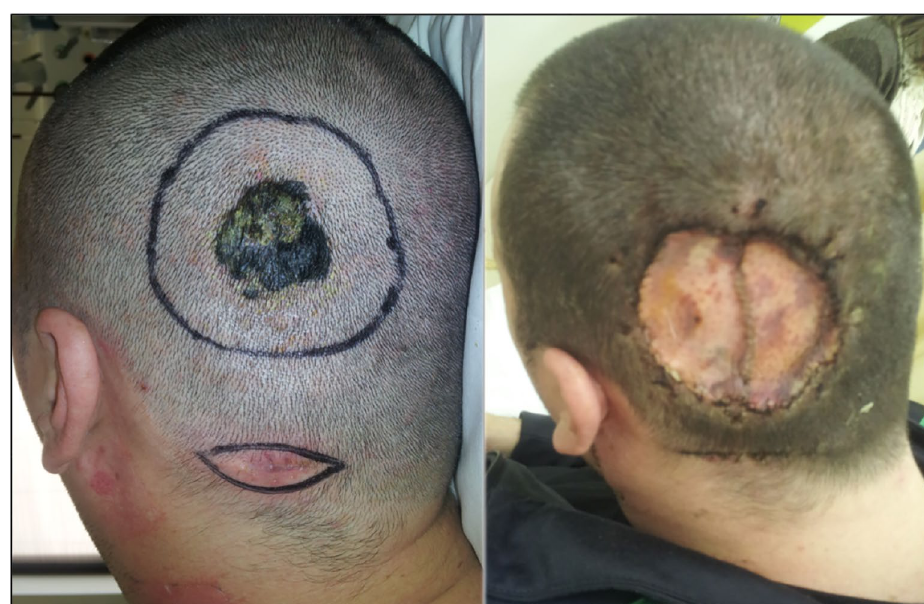
Figure 2. Clinical image of a 28-years-old man with a superficial spreading melanoma, with a Breslow thickness of 3.3 mm. This thick melanoma required complex